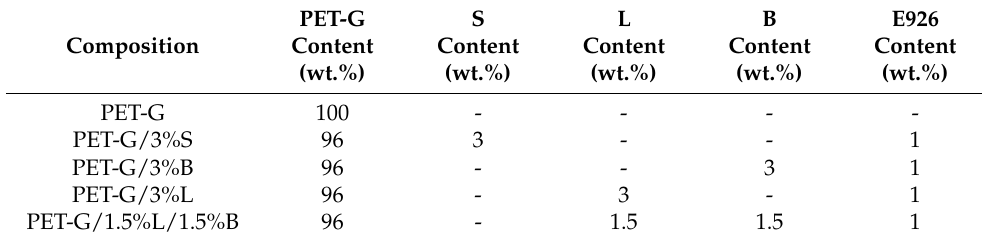
Table 1. Compositional data of the composites.